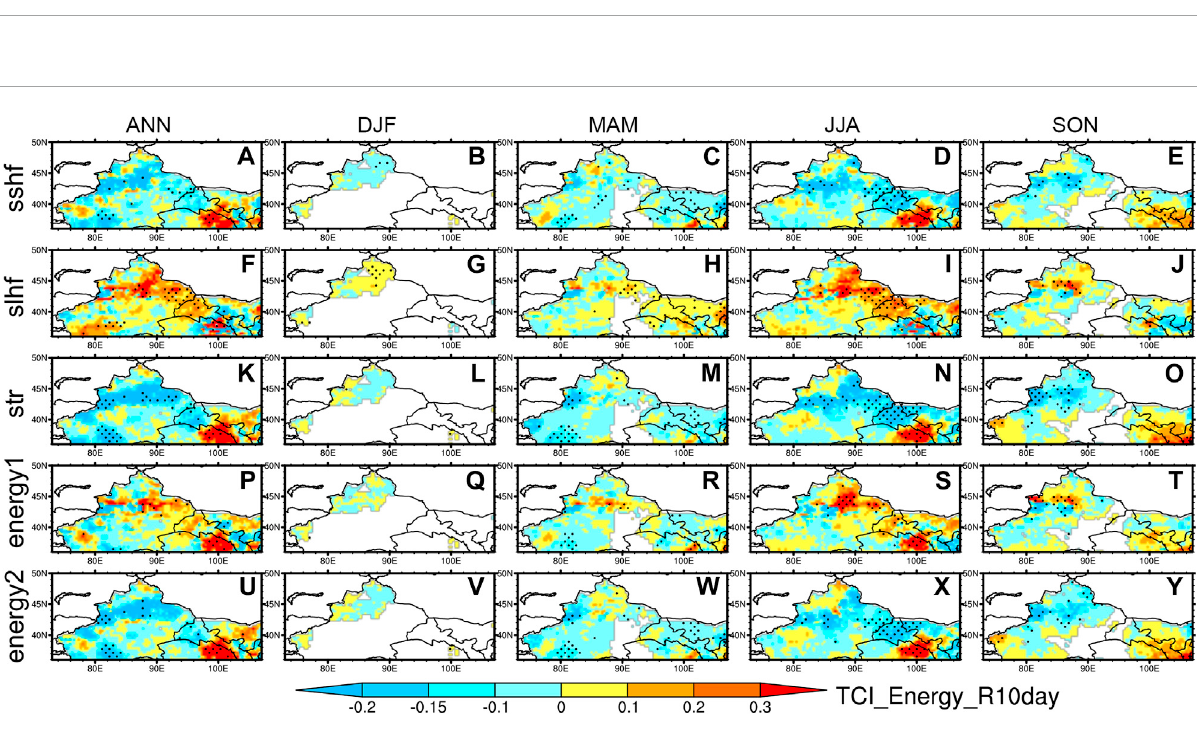
FIGURE 11 Spatial distributions of the annual and seasonal coupling index of sshf, slhf, str, energy1, and energy2 with R10day. The rest of the caption is the same as in Figure 6.